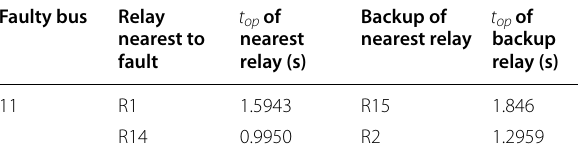
Table 1 TMS and t op of the nearest relay to fault and